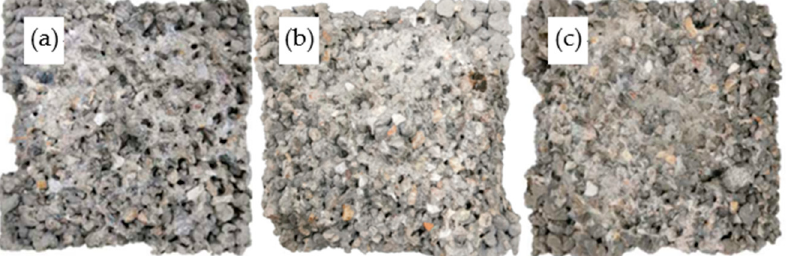
Figure 8. Surface changes of control PCPC after abrasion test. ( a ) Without wet-dry cycles, ( b ) 12 wet-dry cycles in water, and ( c ) 12 wet-dry cycles in acid rain.